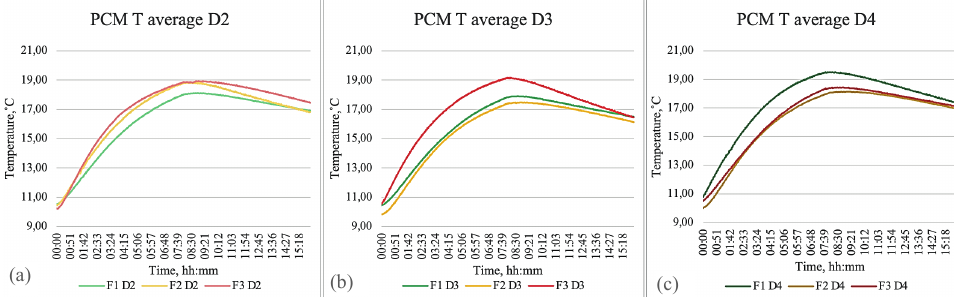
Fig. 7. Average temperatures in PCM container in all the Setups by cone diameter: (a) – D2, (b) – D3 and (c) – D4. In the Setups with focal point location F1, the highest average temperature in PCM is reached with the widest cone diameter – D4. However, moving the focal point closer to the center of the PCM container gains higher average PCM temperatures with cone diameters D3 and D2. The graphs of setups F2 D2 and F3 D3 indicate a steeper temperature drop during the ‘nighttime’ period compared to other setups with the same focal point location. A similar tendency can be observed in Fig. 7 diagrams, where steeper ‘nighttime’ period curves (i.e., temperature drop) appear by enlarging the cone